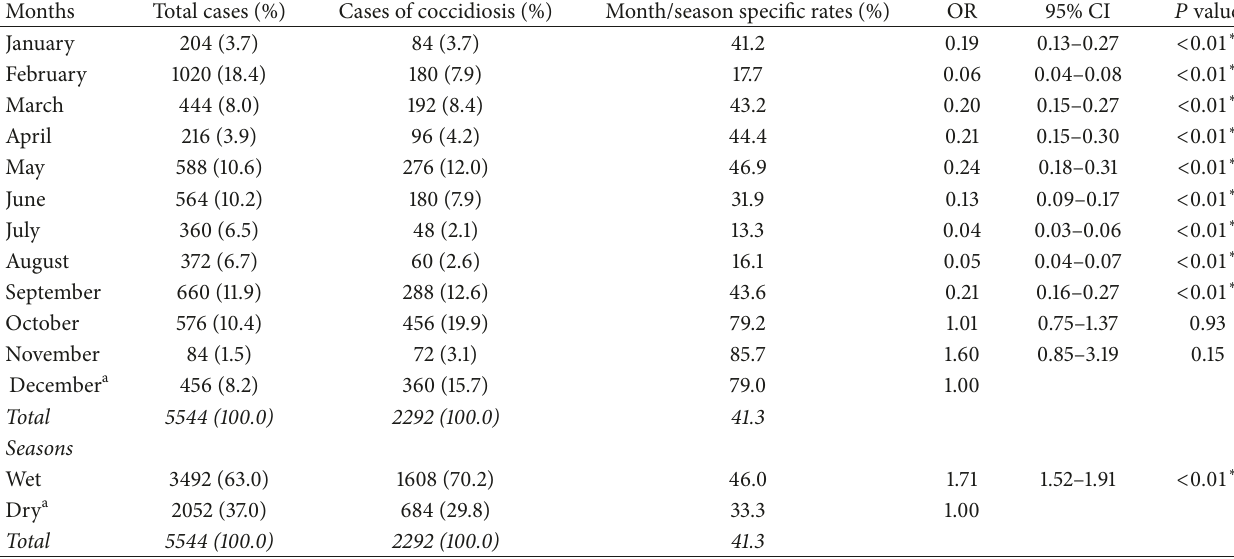
Table 2: Monthly and seasonal distribution of avian coccidiosis in Osun State, Nigeria